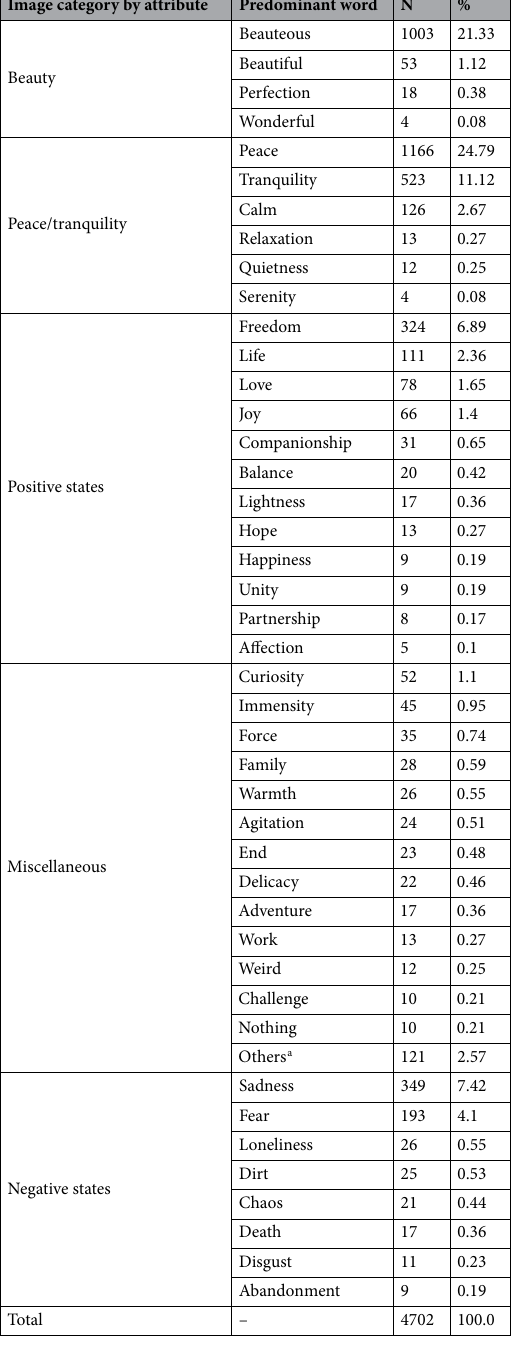
Table 7. Distribution of mentions according to the predominant words assigned by participants. a